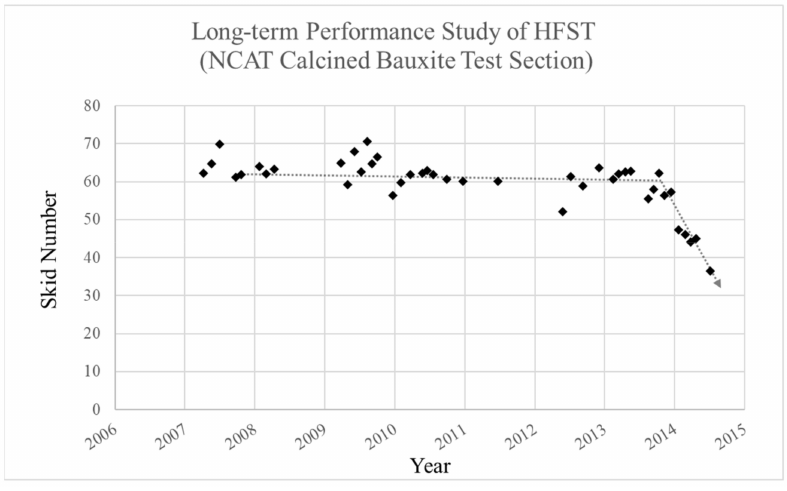
Figure 2. Evolution of friction of a HFS surface. Data courtesy of